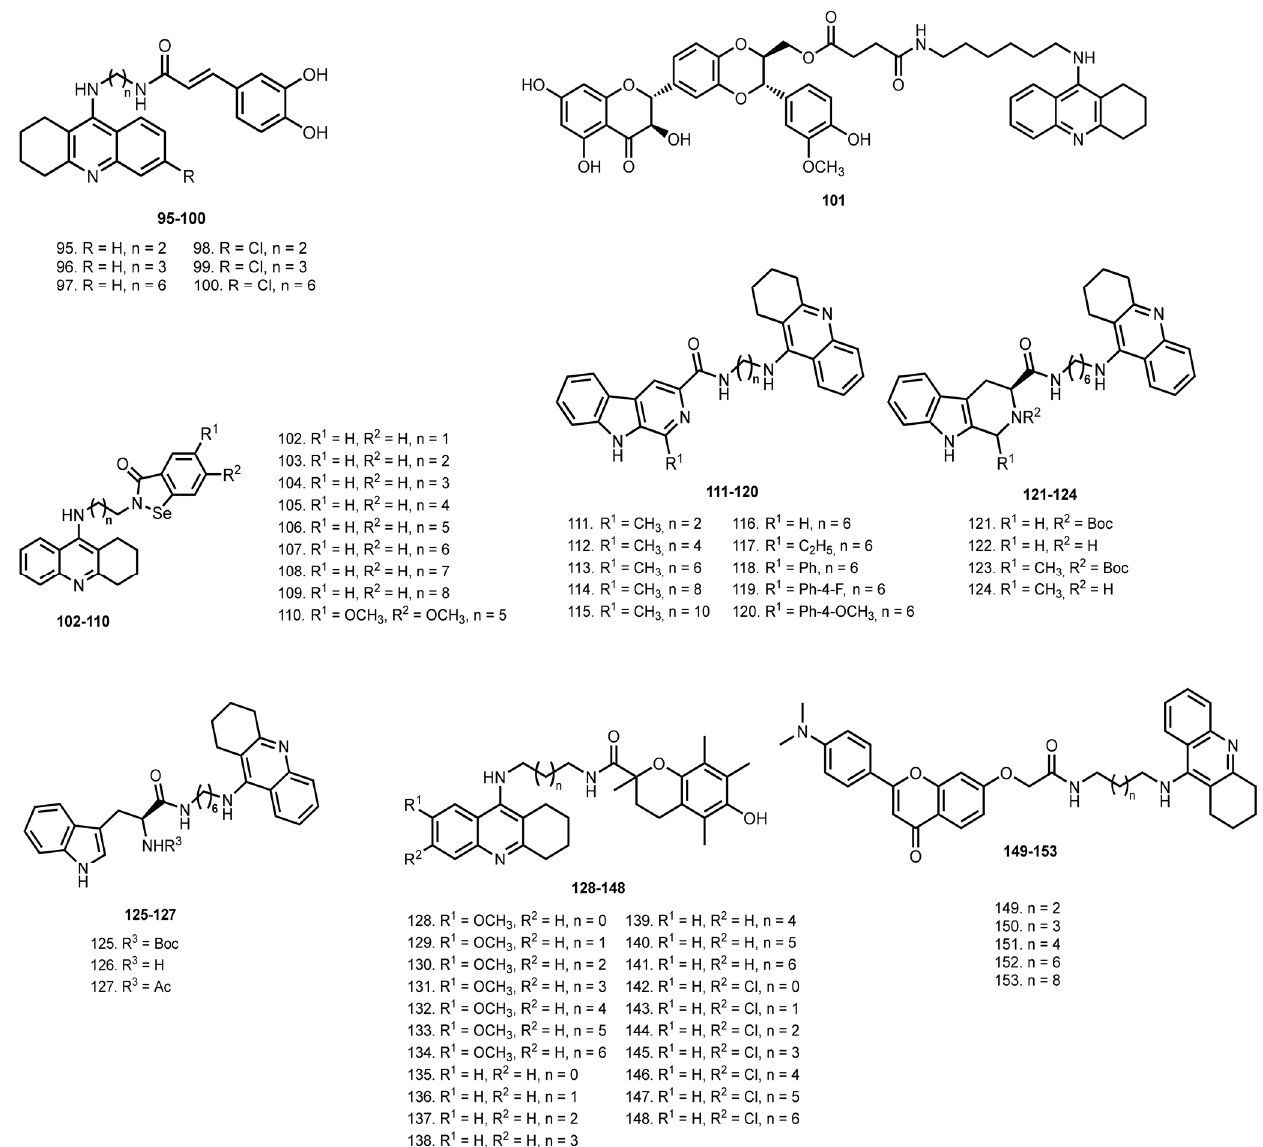
Figure 6. THA–caffeic acid hybrids 95 – 100 [46], THA–silibinin hybrid 101 [47], THA–Ebselen hybrids 102 – 110 [49], THA–(b-carbolines (pyrido [3,4-b]indoles) hybrids 111 – 127 [50], THA–trolox hybrids 128 – 148 [51], THA hybrids with N,N-dimethylated flavonoids 149 – 153 [52]. In 2013, Mao et al. reported THA hybrids with Ebselen 102 – 110 , an organoselenium with antioxidant activity, anti ‐ inflammatory, and neuroprotective activities [49,137,138]. Hybrids 102 – 110 inhibited both AChE and BuChE with nanomolar activity. Hybrid 106 was the best AChE inhibitor with IC 50 6.32 nM among the derivatives with unsubstituted Ebselen moiety, whereas 110 with OMe ‐ substituent showed a promising result in 2.55 nM. Lineweaver–Burk plots of 110 against AChE revealed a mixed ‐ type inhibition, which was also confirmed by molecular modelling. Expectedly, 106 and 110 proved to be anti ‐ oxidants with eroxynitrite scavenging activity 1.17 and 1.26 times greater than that of eb ‐ selen, respectively. Unfortunately, 110 showed high toxicity on human hepatic stellate cells (HSC). In 2014, Lan et al. reported THA–(b ‐с arbolines (pyrido [3,4 ‐ b]indoles) hybrids 111 – 127 [50]. All hybrids inhibited both ChEs with IC 50 values from sub ‐ micromolar to nano ‐ molar. Hybrid 122 was the best AChE inhibitor with IC 50 21.6 nM and 125 was the best